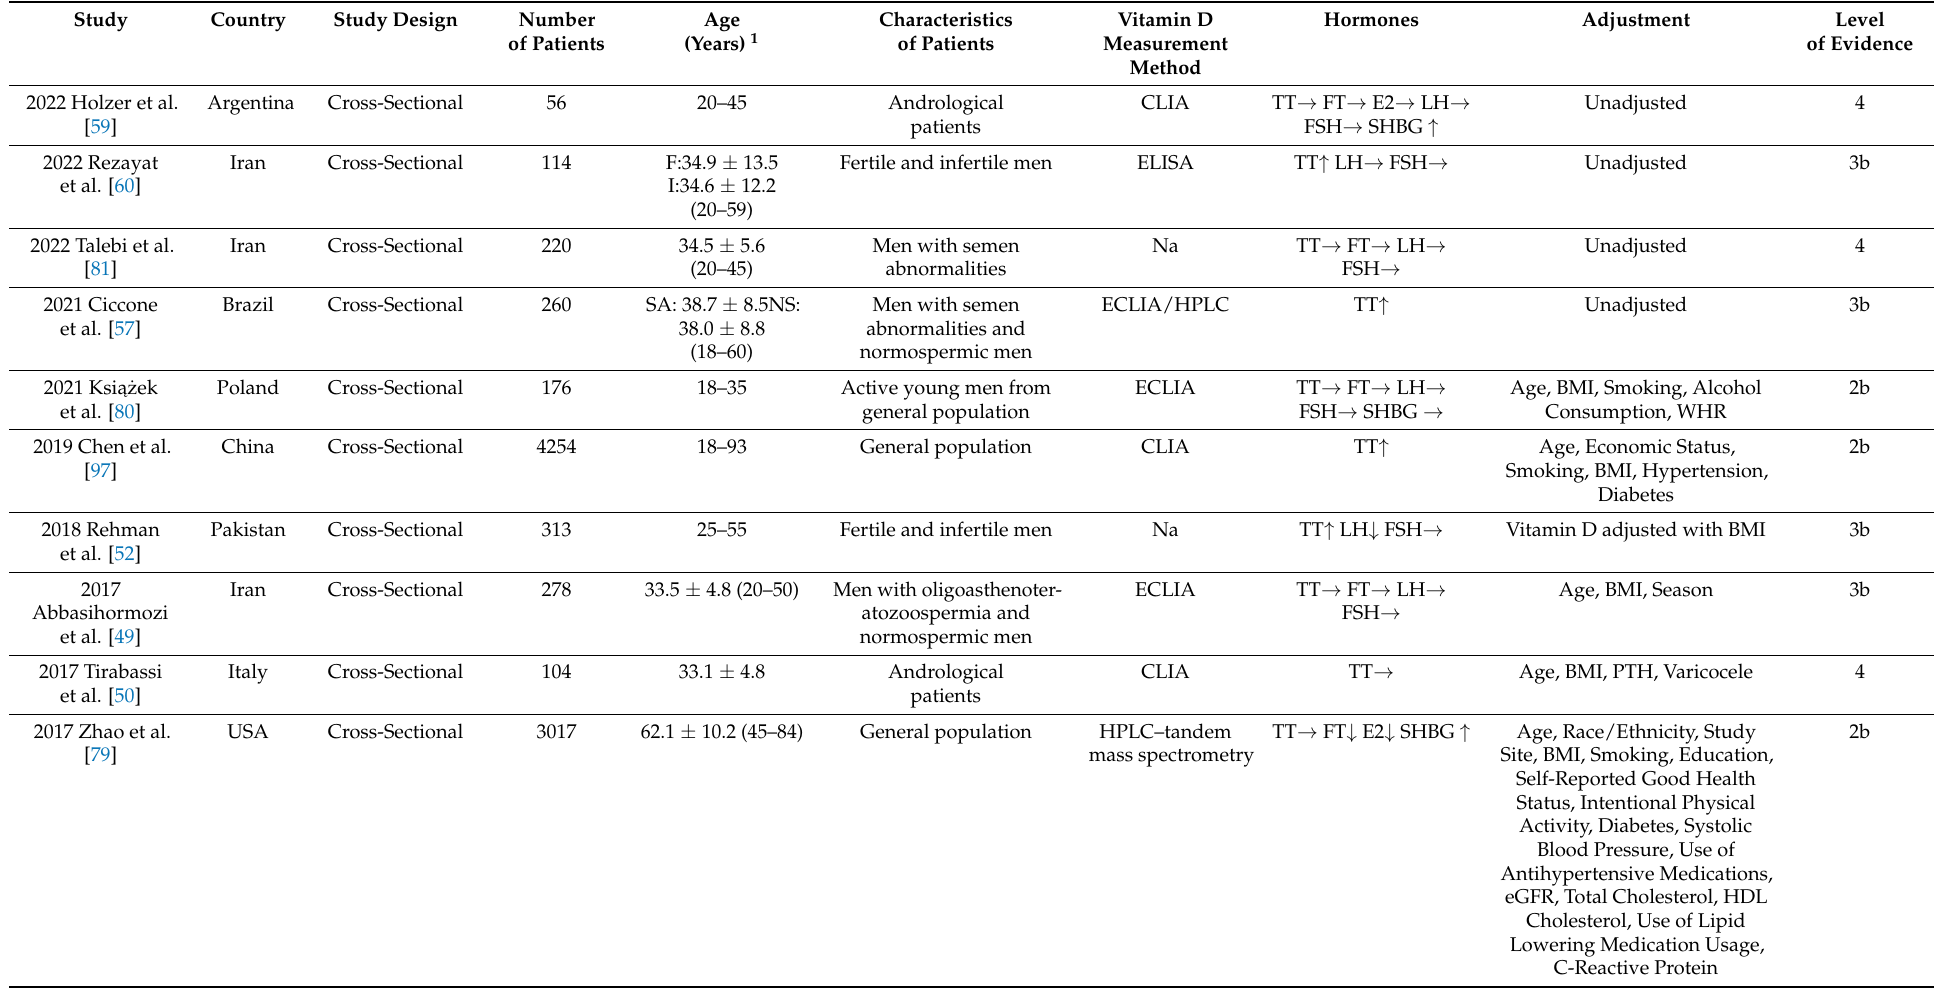
Table 3. Summary of observational studies between vitamin D and sex steroids in